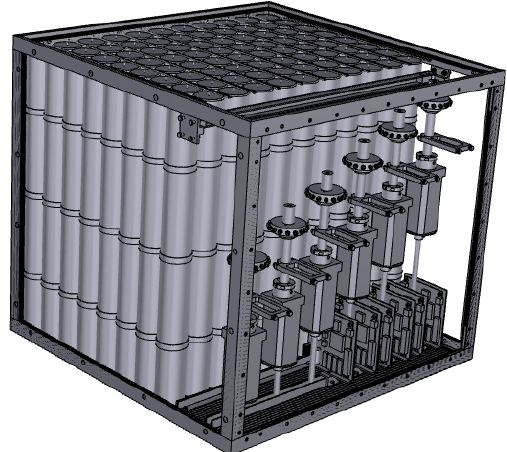
Figure 1. Schematic view of the 88 sample cylinders inside the HIRES unit and the six multiposition valves. For simplicity all tub- ing is omitted to illustrate only the positioning of these main com- ponents. Drawing: Laurin